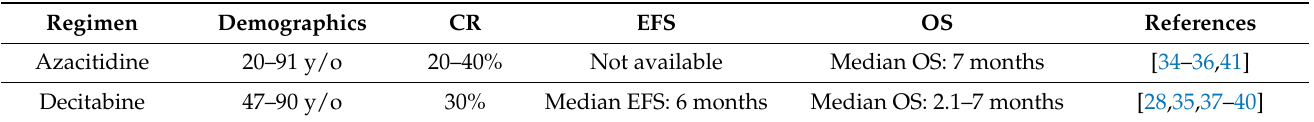
Table 2. Outcome of TP53 -mutated myeloid malignancy patients treated with hypomethymating agents. CR: Complete Remission, EFS: Event Free Survival, OS: Overall Survival.